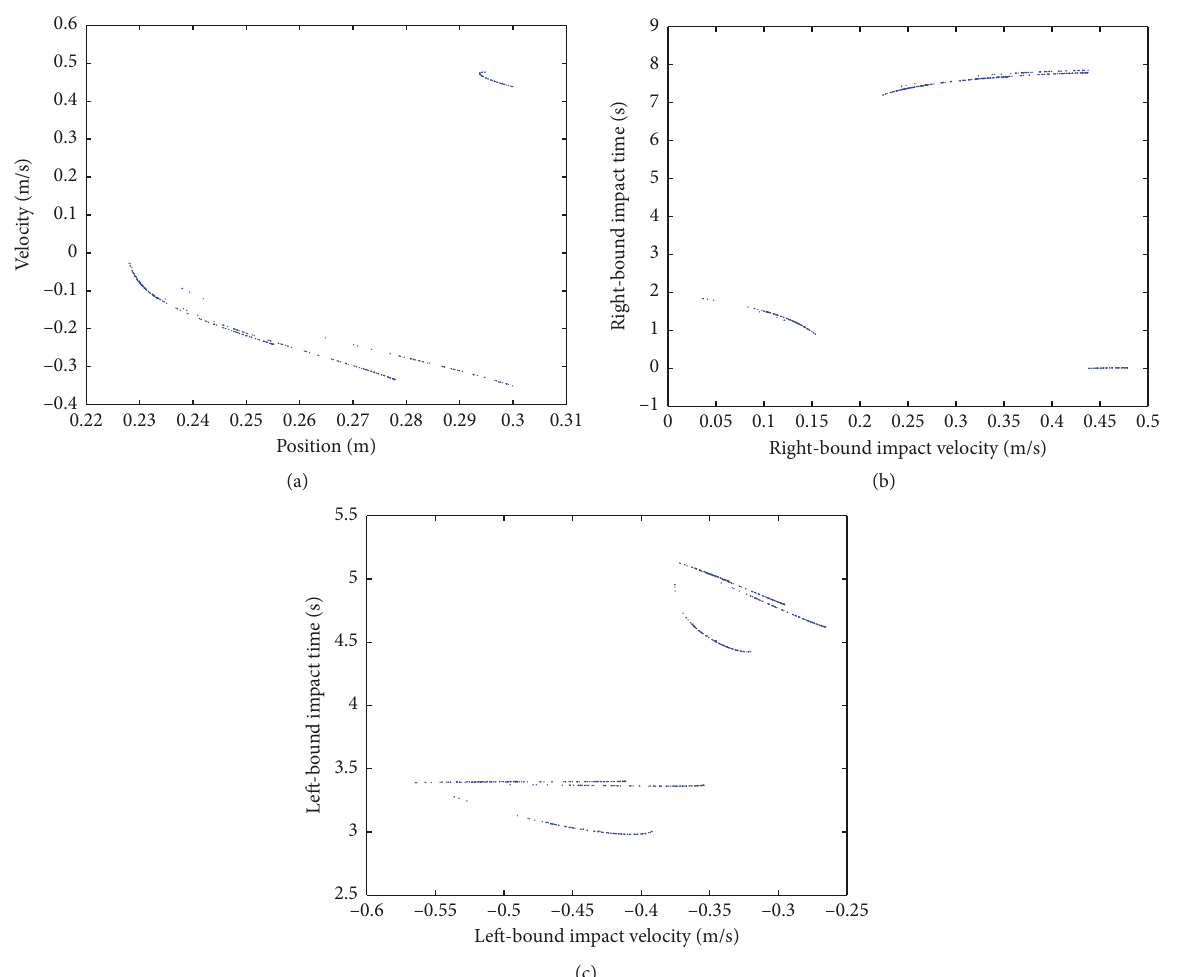
Figure 4: Phase portrait of the double-sided 1-DoF impacting mechanical oscillator for the parameter w � 0 . 8 showing a chaotic